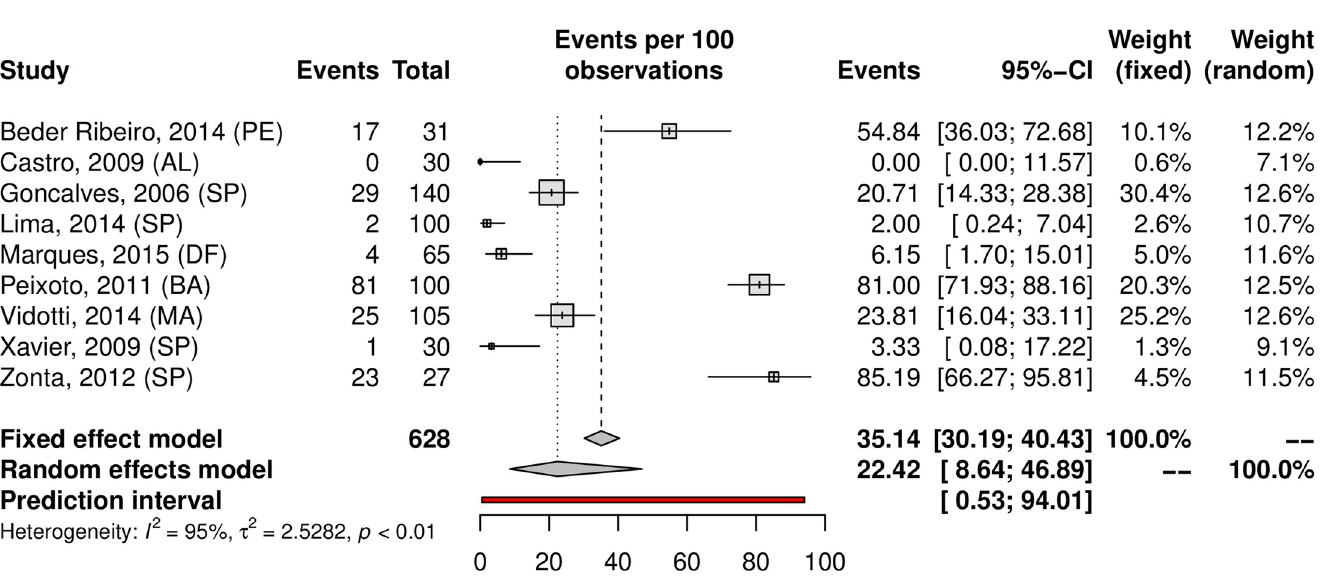
Fig 24. Prevalence of oral HPV infection in high-risk populations. Forest plot of a metanalysis of studies reporting prevalence of oral HPV infection in high-risk populations in Brazil.